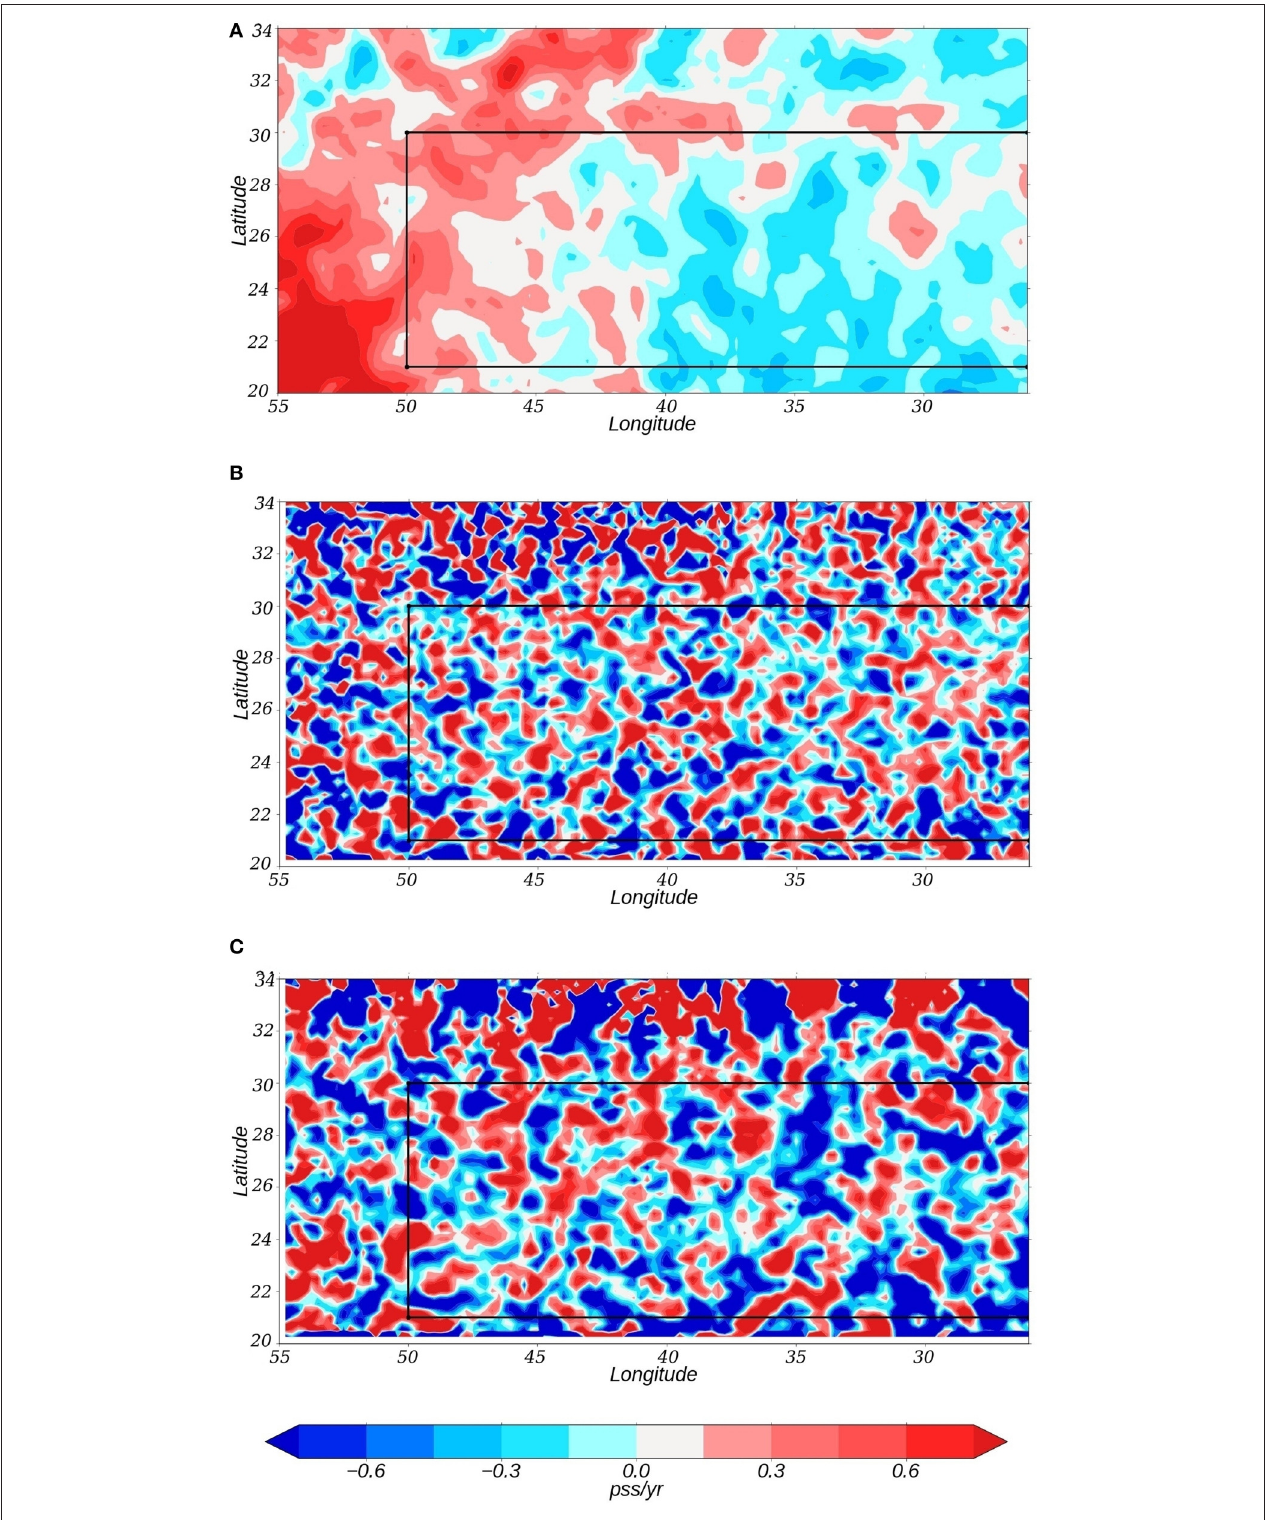
FIGURE 7 | Terms of the Equation (1) averaged over the year August 2012—August 2013; (A) —time salinity change, (B) —turbulent advection term, (C) —mean advection term.